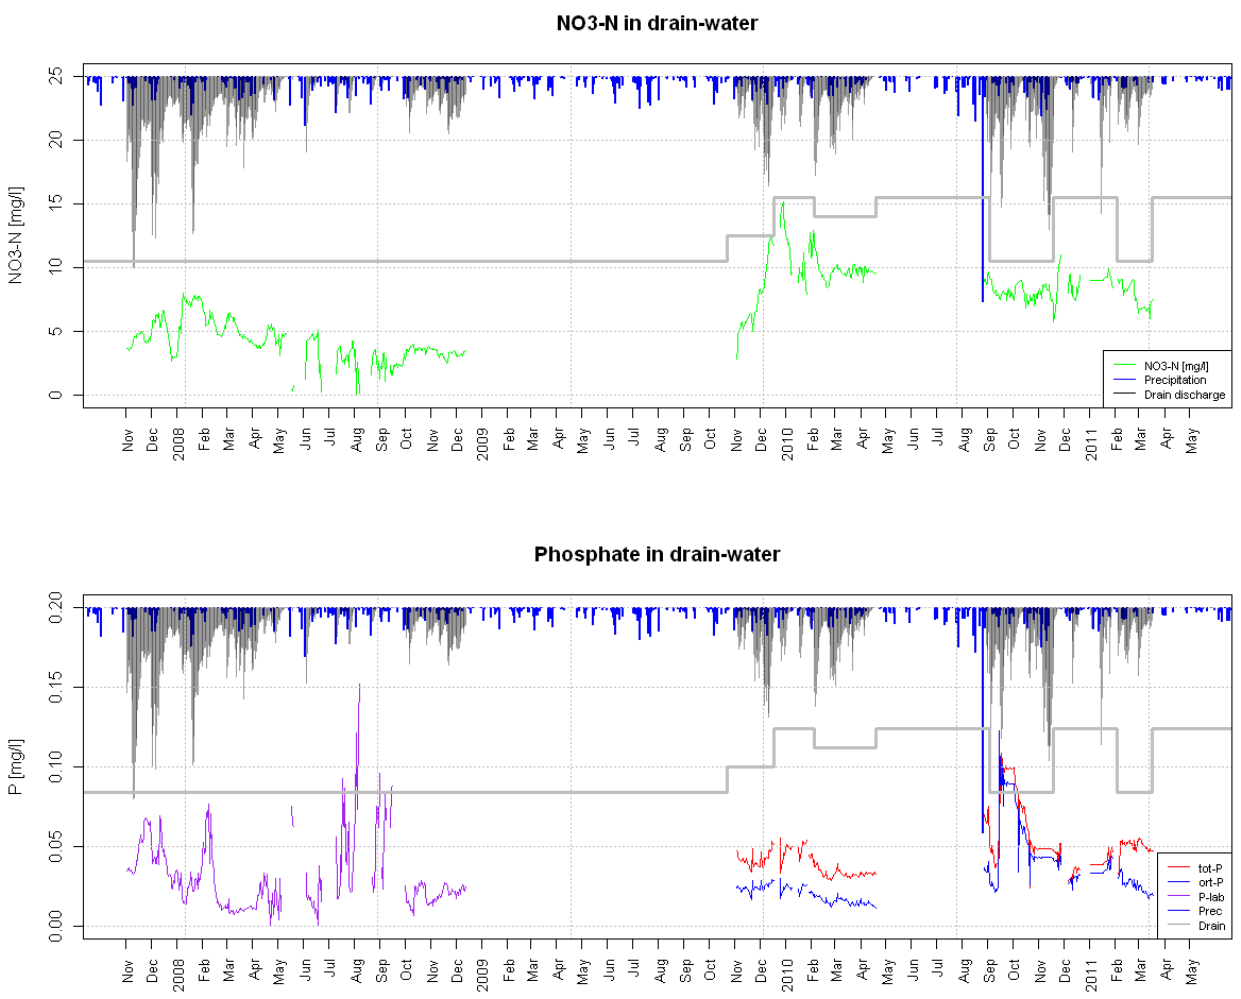
Figure 6. Measured nutrient concentrations in drain effluent. Precipitation (blue), drain discharge (grey), and the overflow levels are also